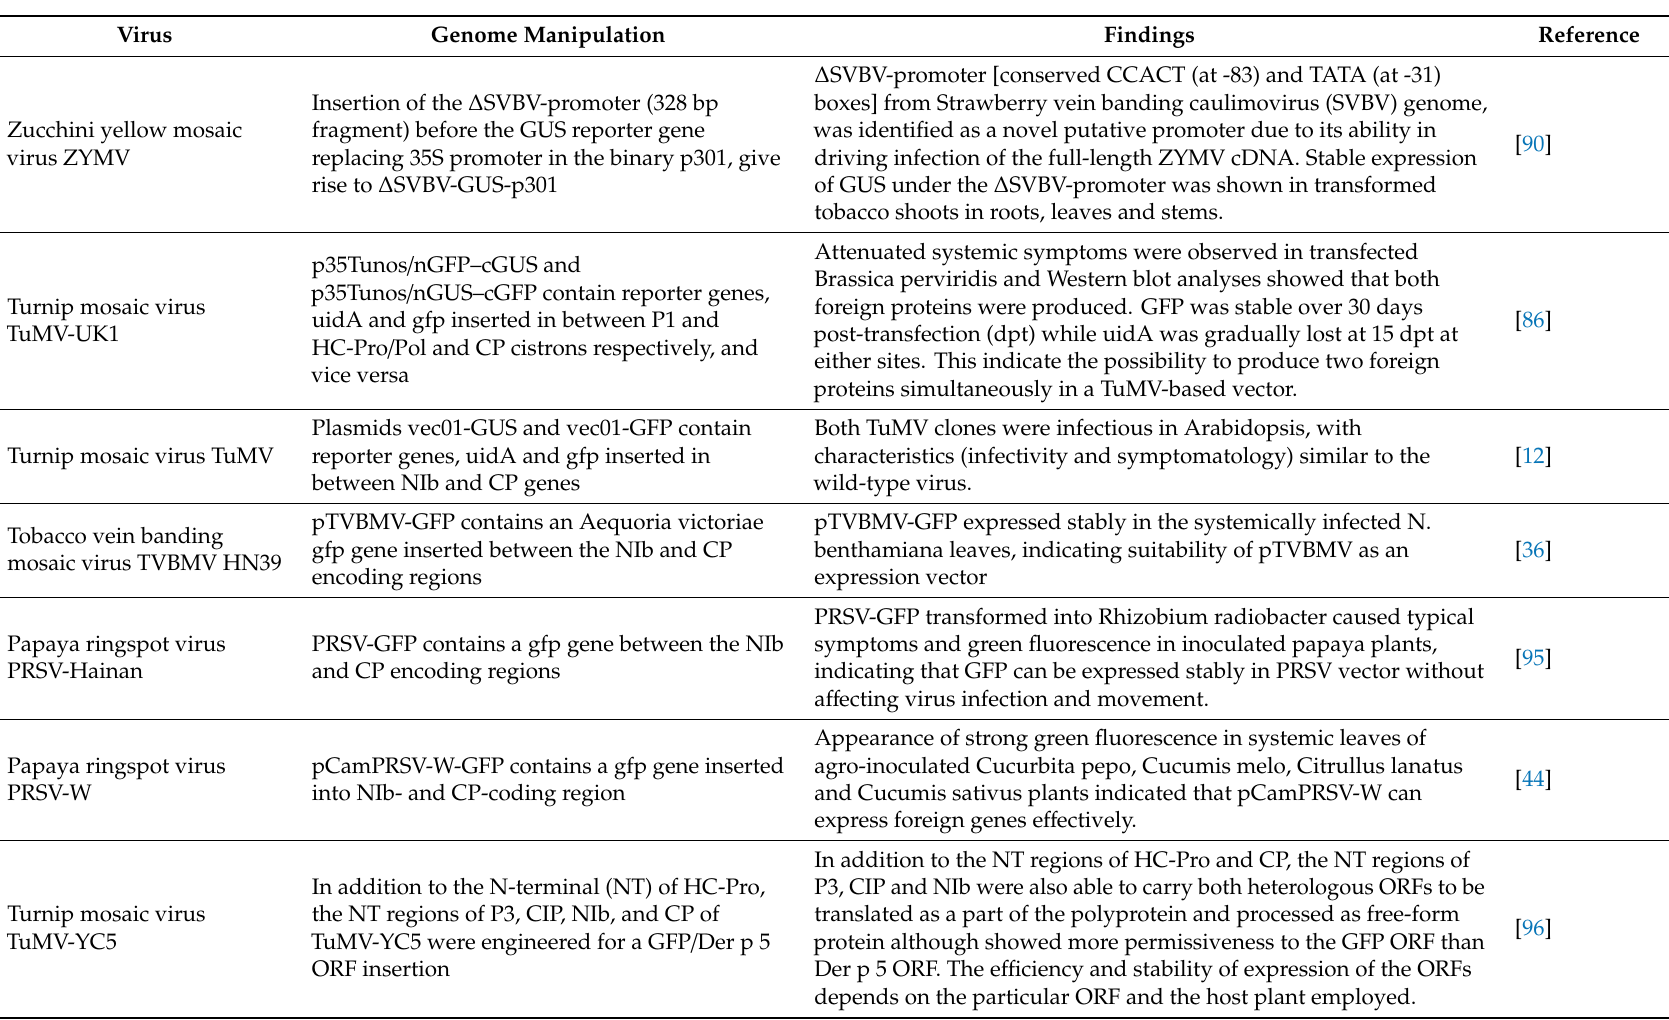
Table 4. Potential of potyviruses as expression vectors for the monitoring of viral infections in host